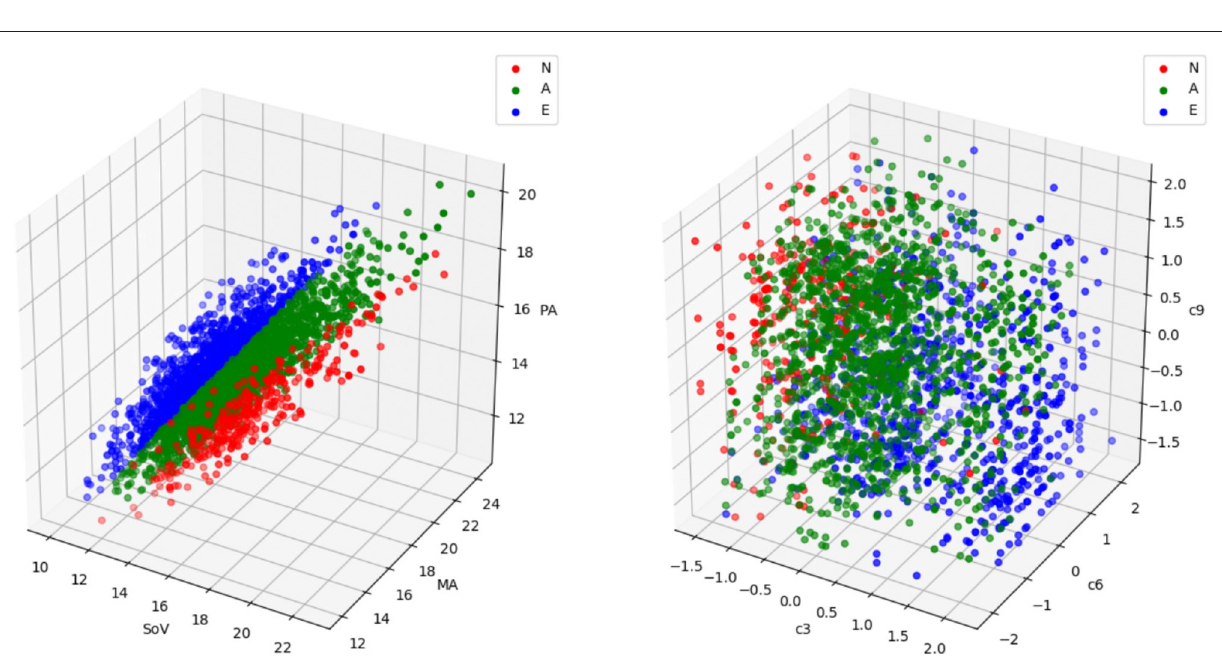
FIGURE 2 | A sample with the three aortic root phenotypes (labeled as N , A , and E ) defined in Schaefer et al. (2008) represented in the biomarkers space (left) and in the feature space (right). Each point represents an aorta. In the biomarkers representation, the coordinates correspond to the three biomarkers involved in the phenotype definition, in millimeters (refer to Figure 1 and Table 1 for acronym meanings and phenotype definitions). In the feature space representation, the coordinates are the coefficients of the three deformation modes, c 3 , c 6 and c 9 , that are most discriminant in this problem. Phenotype N is represented in